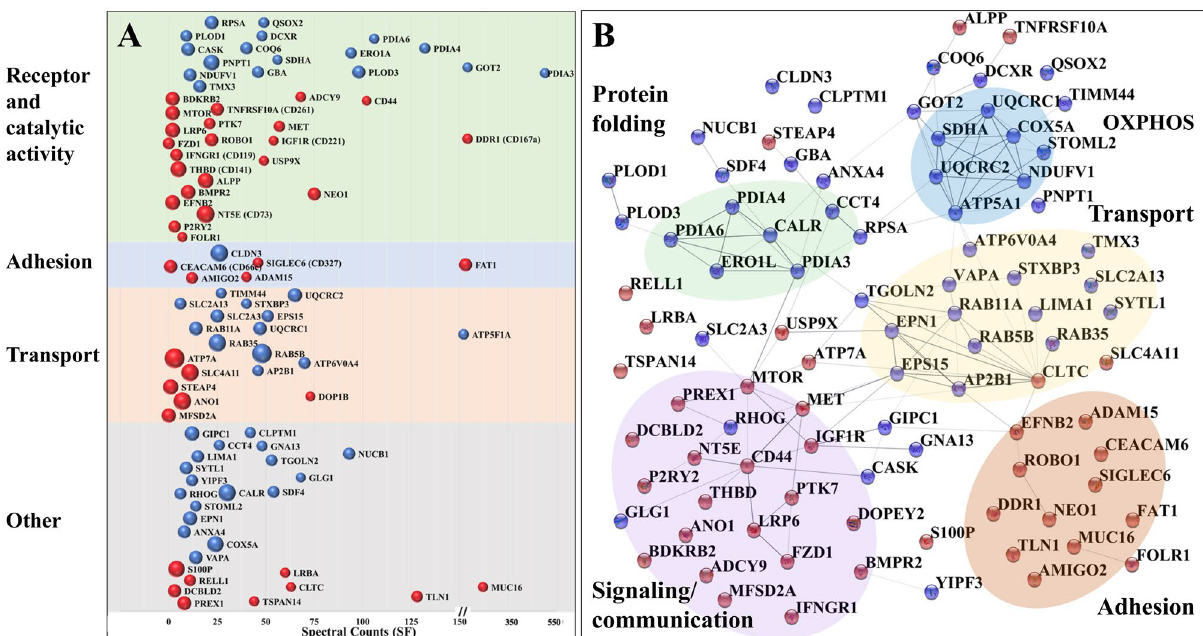
Figure 9. Proteins with changed abundance in the cell-membrane proteome. ( A ) Proteins with increased (red) and decreased (blue) abundance in ST vs. SF cells, categorized by function (y-axis) and spectral counts in SF cells (x-axis); the sphere size is proportional to the log2(FC) in protein spectral counts. ( B ) Cytoscape visualization of the STRING PPI network created with the proteins that displayed a change in abundance (same color scheme as in A